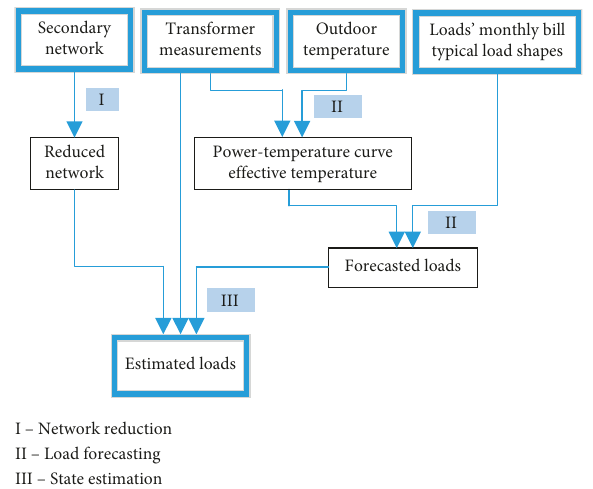
Figure 3: Schematic diagram of proposed load estimation